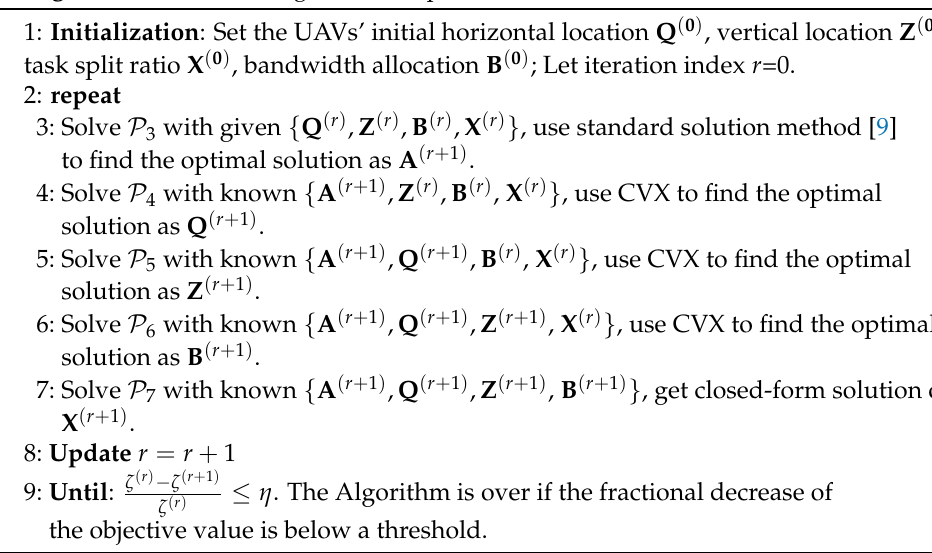
Algorithm 1: Iterative algorithm for problem P 1